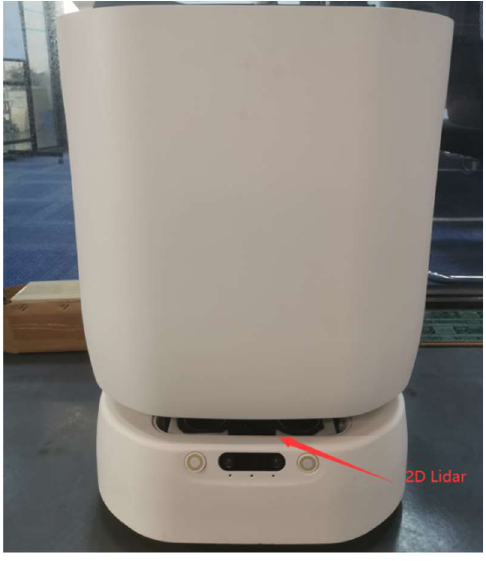
Figure 6. Test platform.